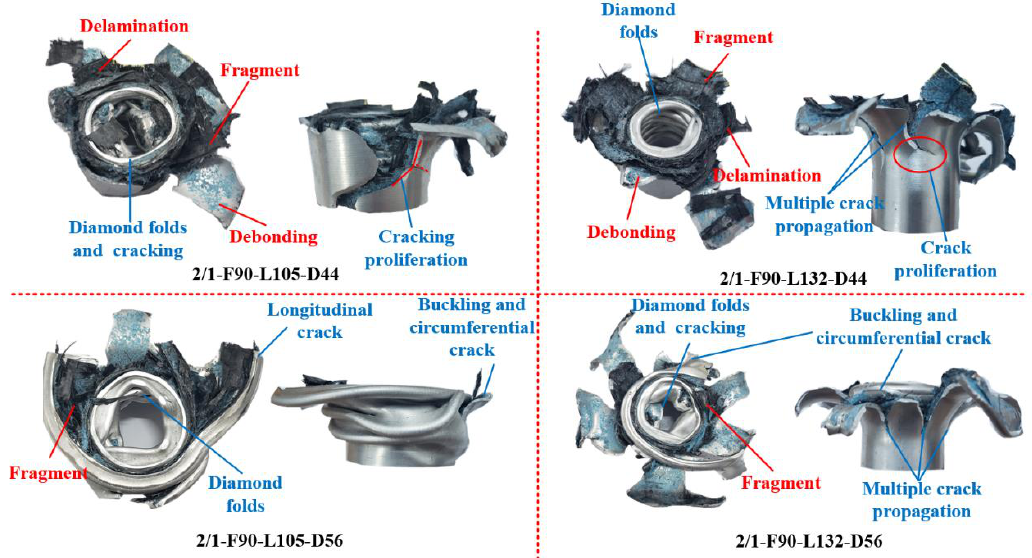
Figure 13. Final failure modes of 2/1 hybrid tubes with [0°/90°] lay-up